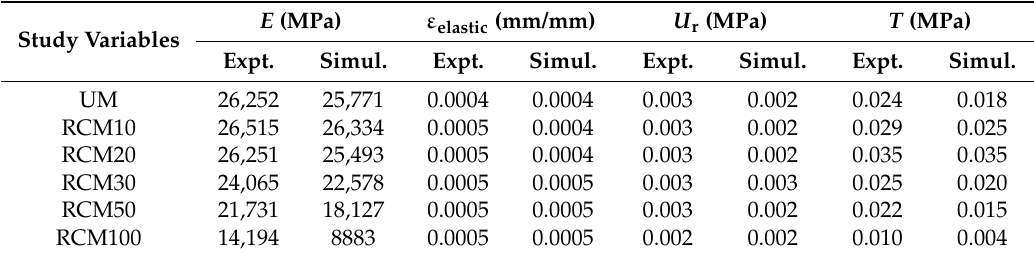
Table 6. Values of the experimental properties and those determined through simulation .